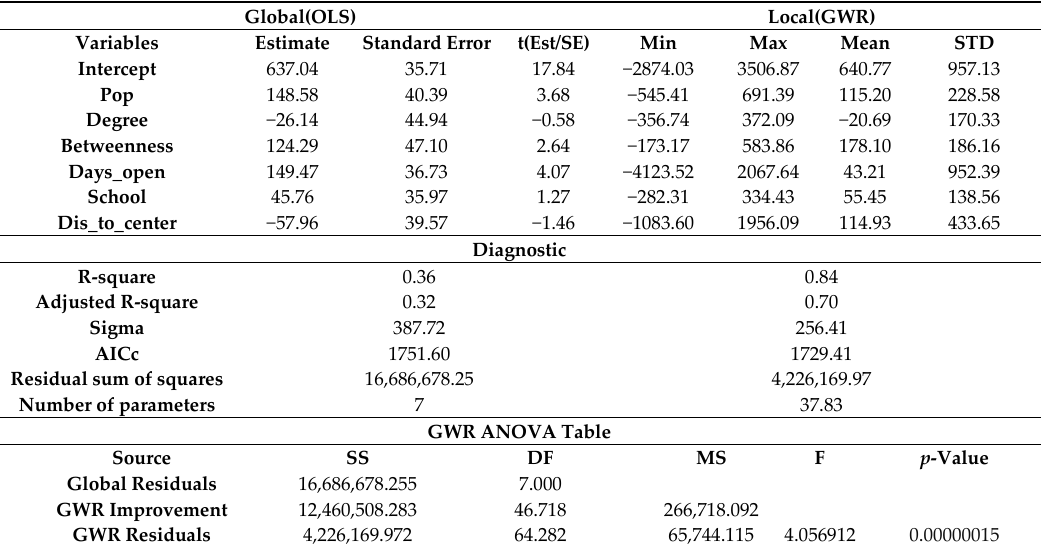
Table A4. Results of the model for Evenrush_ridership.